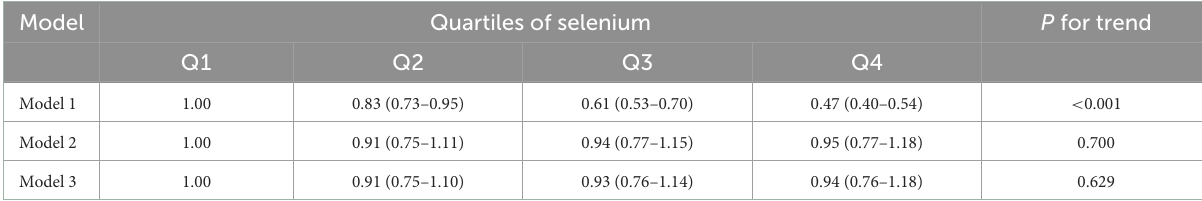
TABLE 3 Association between dietary selenium and rheumatoid arthritis using logistic regression. Model